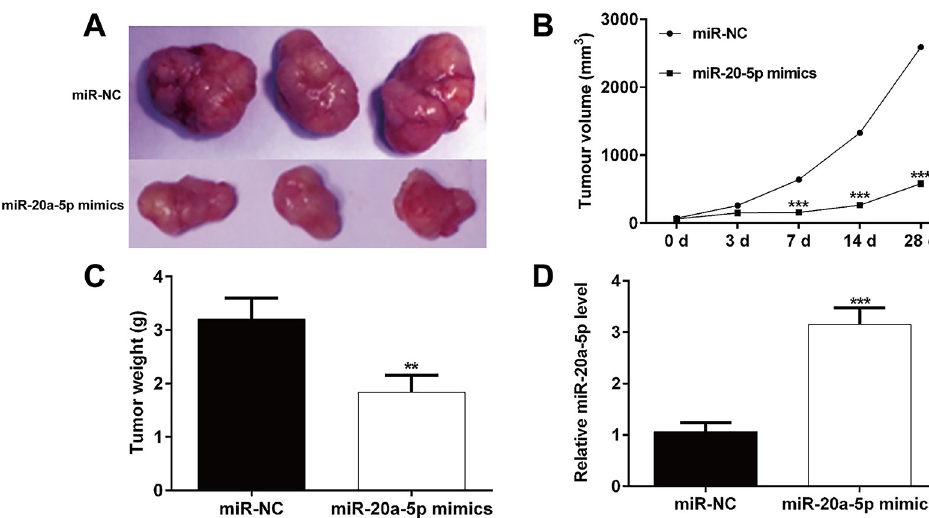
Fig 6. MiR-20a-5p inhibited tumorigenicity in vivo. (A) Representative photographs of tumors were obtained from the different groups of nude mice (n = 5 per group) transfected with miR-20a-5p -mimics, and miR-NC. Tumors were observed by (B) tumor volume and (C) average weight. (D) Expression of miR-20a-5p was detected by quantitative real time PCR. Data are presented as mean ± SD of three independent experiments. �� p < 0.01, ��� p < 0.001, compared with